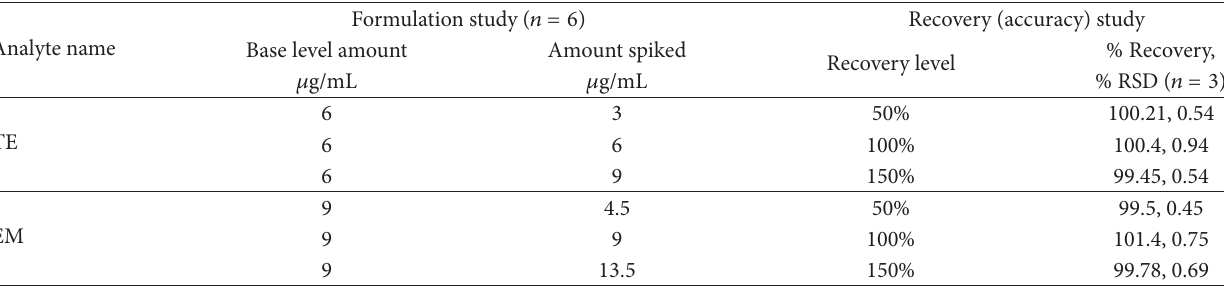
T 2: Result of recovery studies for TE and EM.